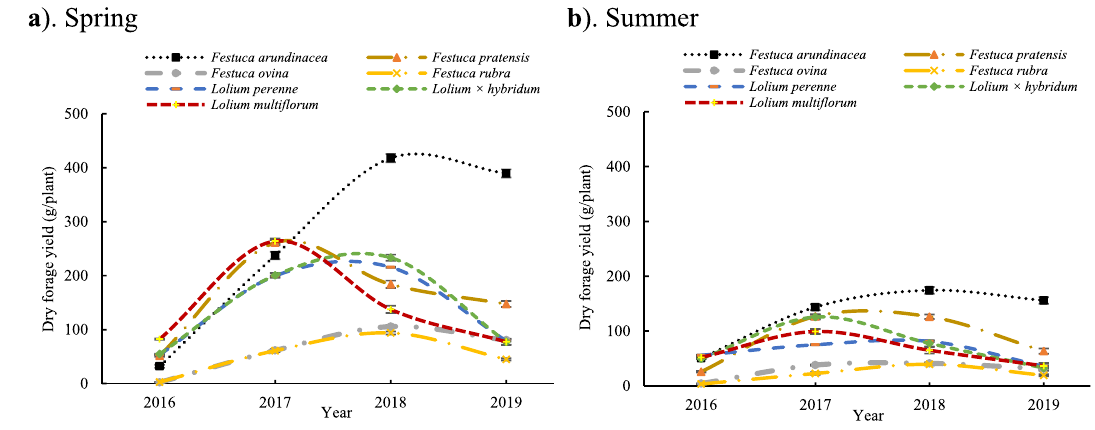
Figure 1. Trends of spring and summer dry forage yield (DFY) over years (2016–2019) in seven grass species subjected to normal irrigation condition. Error bar in each point is standard error in every year.